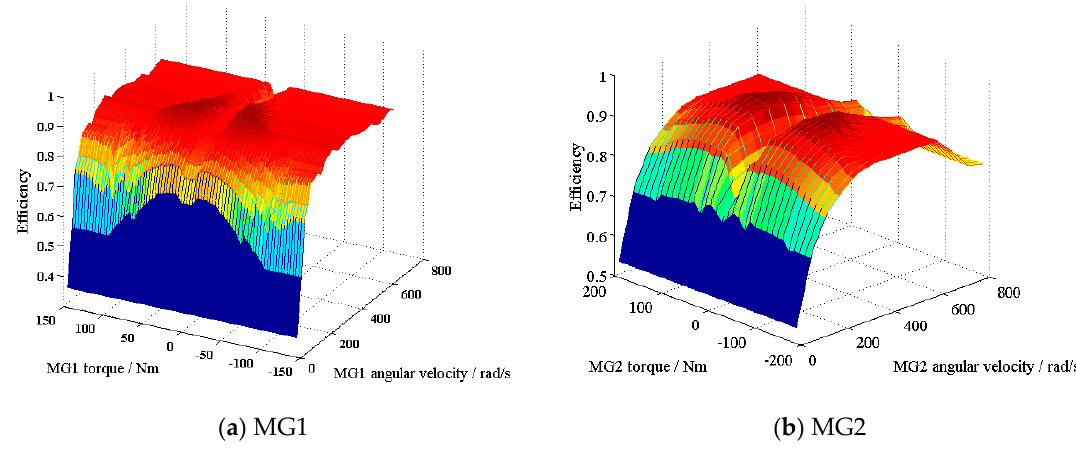
Figure 3. Efficiency map of motor. Figure 3. E ffi ciency map of